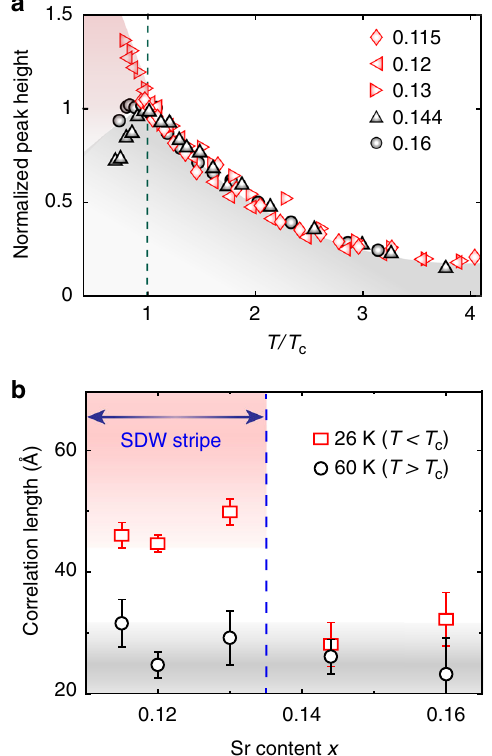
Fig. 4 Comparison of CDW correlations with and without the SDW stripe order in LSCO. a Temperature dependent CDW peak heights for x < x sdw (red) and x > x sdw (black). Both the peak heights and temperatures are normalized to the values at respective T c . b Doping dependent in-plane CDW correlation length for LSCO samples at 26 K and 60 K. The dashed line denotes the x sdw . The colored shades are guides-to-the-eye. The error bars represent 1 s.d